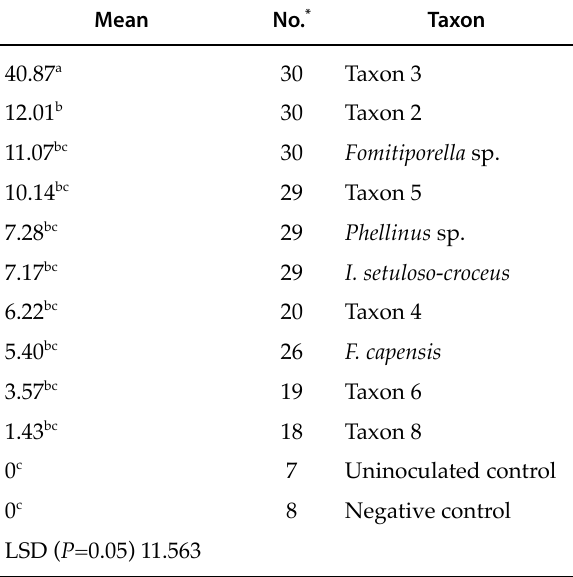
Table 5. Mean white rot lengths (mm) produced in the cor- dons of Mourvédre vines inoculated with representative isolates of Hymenochaetales